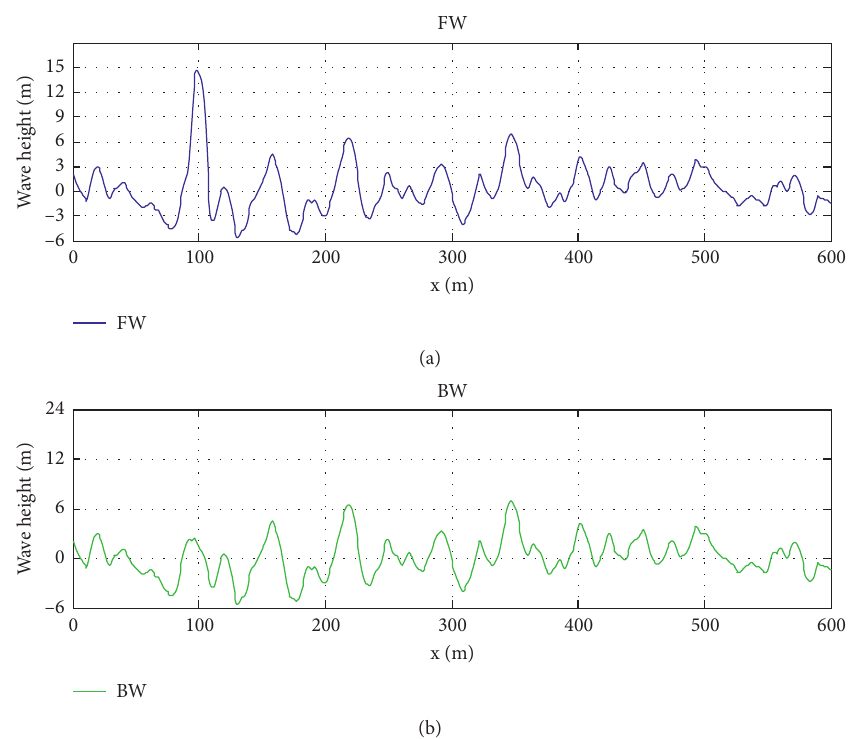
Figure 6: Comparison of the space sequence of freak waves simulated by phase modulation method and their background wave